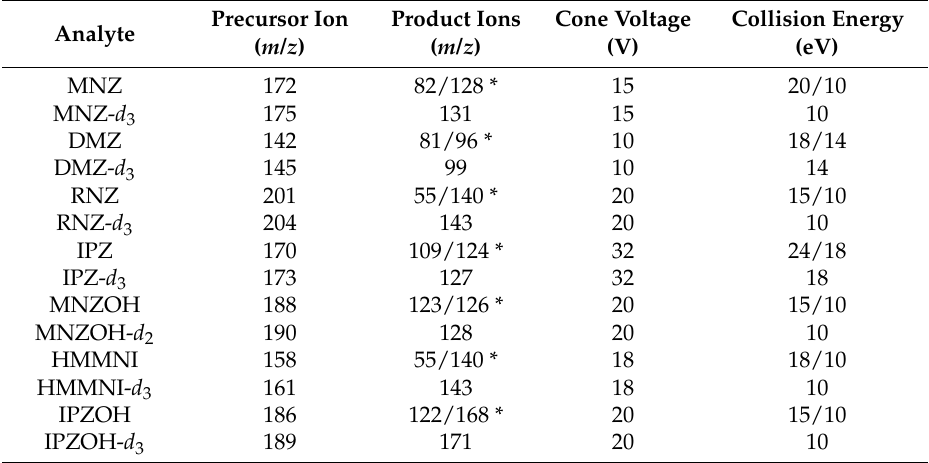
Table 4. MS/MS transitions and optimal